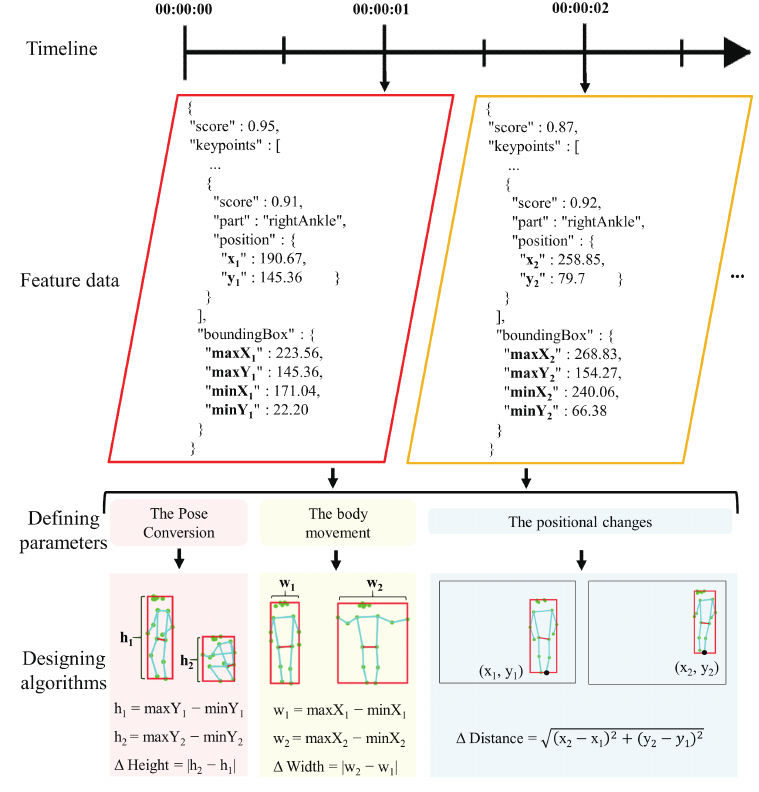
Figure 4. Example of feature data, defining parameters and designing algorithms within the